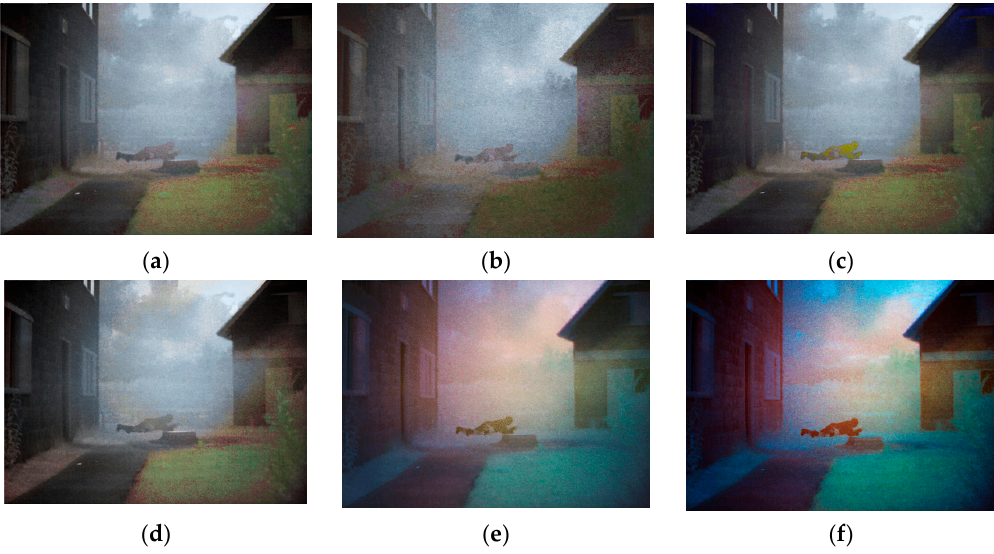
Figure 14. Results from color transformations derived from the standard training set applied to a different scene with different sensor settings in the same environment: ( a ) CTN method; ( b ) LFF method; ( c ) SHT method; ( d ) CTN2 method; ( e ) SCF method; ( f ) R3DF method.